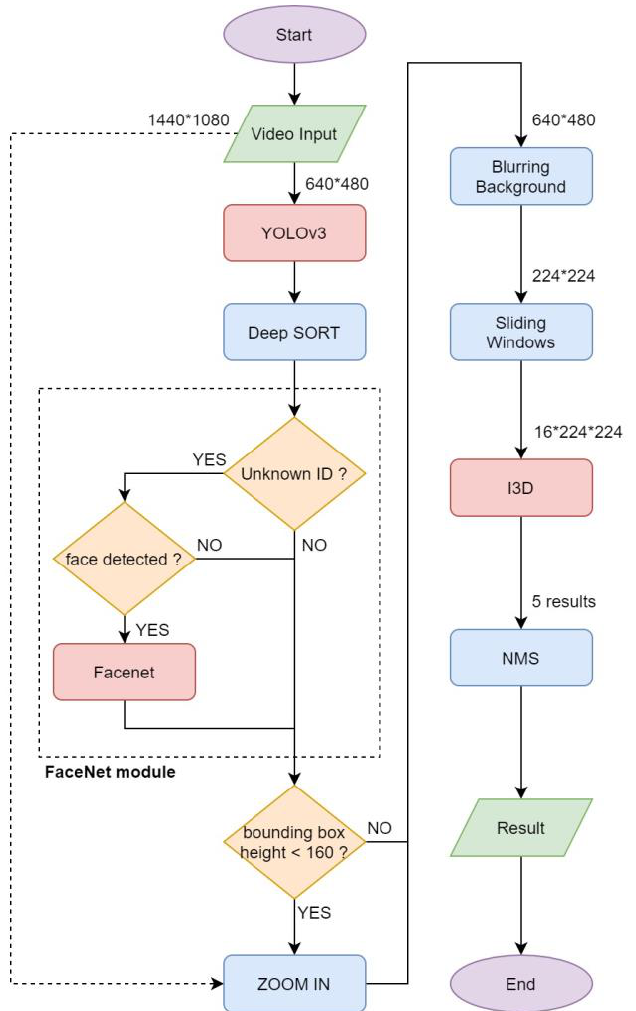
Figure 1. Flow chart of the proposed multiple-person action recognition system (I3D, inflated 3D ConvNet; NMS, nonmaximum suppression).